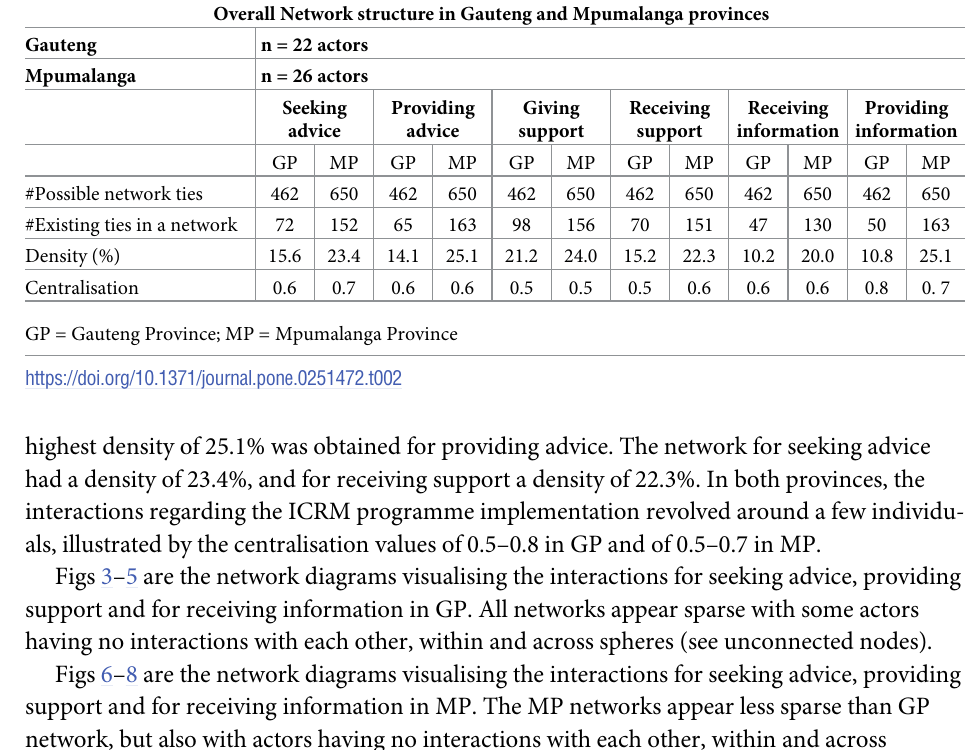
Table 2. Overall network structure in Gauteng and Mpumalanga provinces.